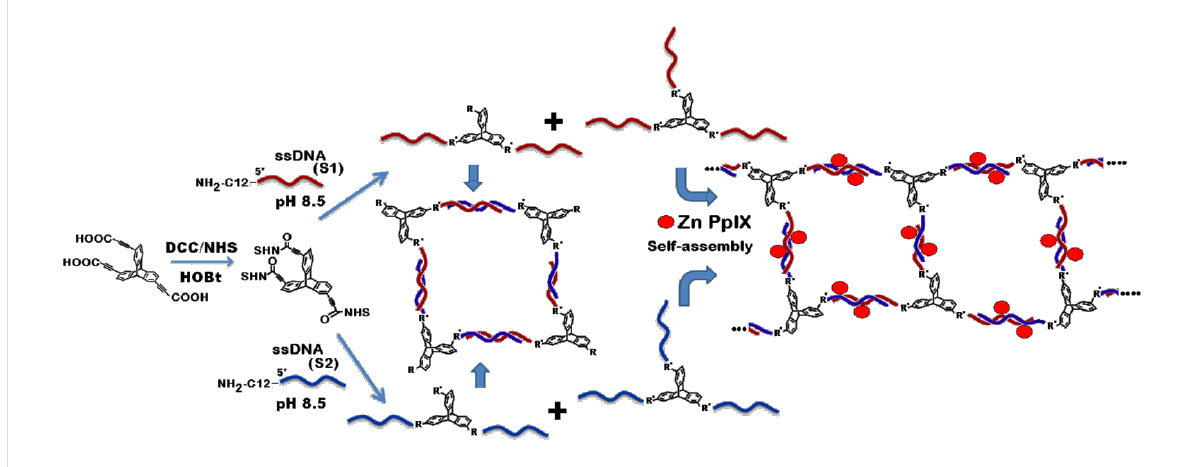
Scheme 1: Schematic representation of creation of nanostructures from DNA–TPA hybrid self-assembly. The number and location of Zn PpIX mole- cules in the scheme are